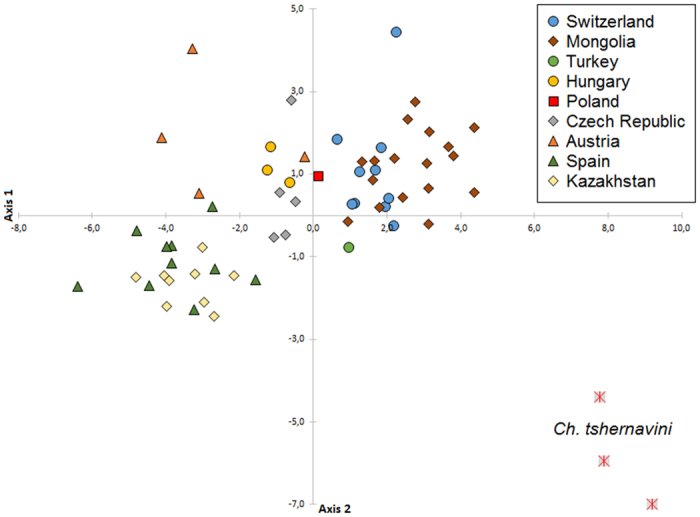
Canonical analysis of 61 specimens of Chaetosiphella stipae stipae (individuals divided according to the place of occurrence) and 3 specimens of Ch. tshernavini based on the analysis of 9 morphological variables and ratios; specimens projected onto the first and second principal axes.